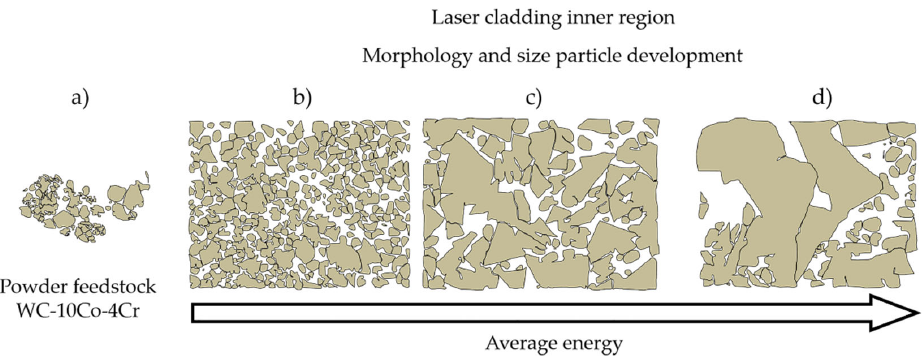
Figure 10. Sequence of WC grain growth ( a ) powder feedstock, ( b ) E a24 , ( c ) E a32 and ( d ) E a39 .